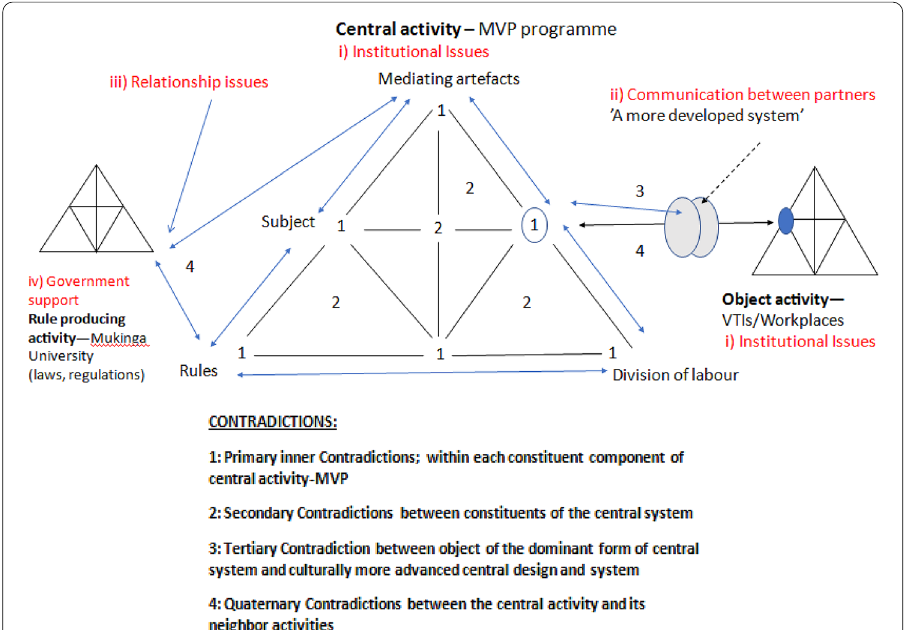
Fig. 1 Three interacting activity systems, contradictions emerging within and between the systems and how they interconnection with strategies and practices for enhancing IWC ( Source: Adopted from Engestrom,